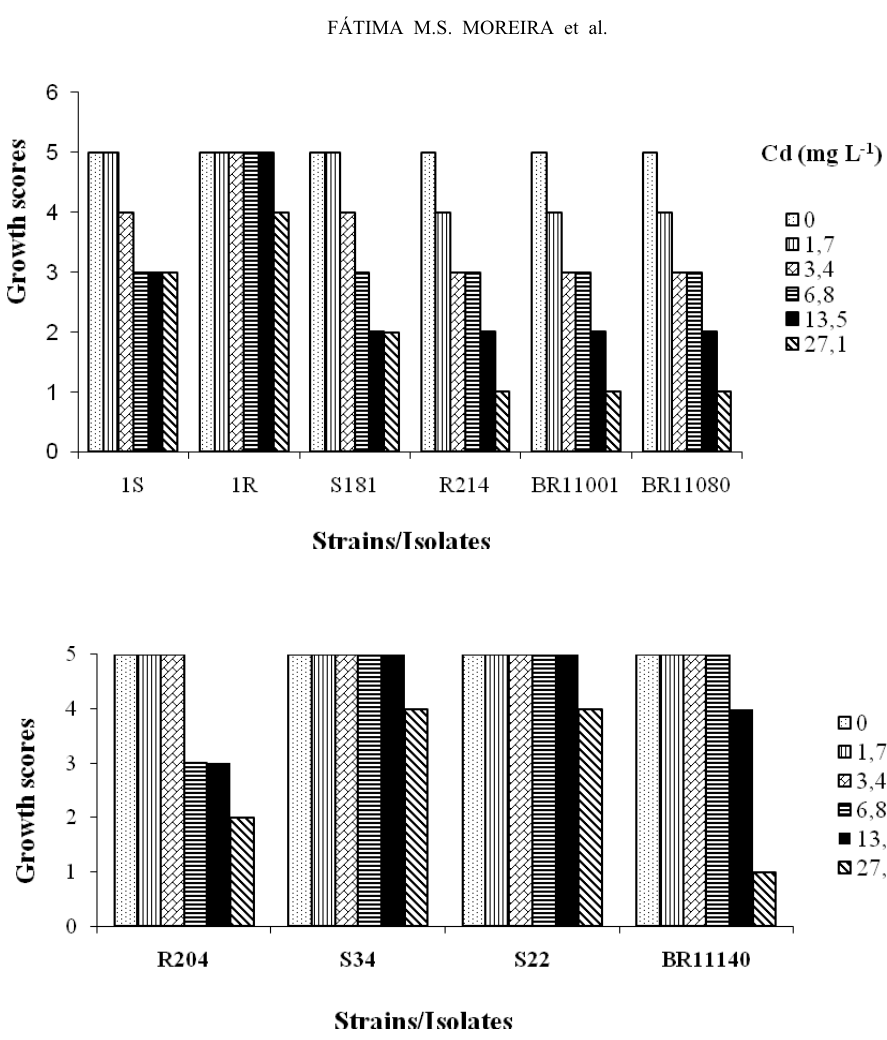
Fig. 2 – Growth scores of associative diazotrophic bacteria isolated from heavy metal contaminated area and type strains in potato dextrose agar medium supplemented with different concentrations of Cd 2+ (mg L -1 ) ten days after inoculation. a) Azospirillum lipoferum (1S and BR 11080 T ) and A. brasilense (1R, S181, R214, BR 11001 T ); b) A. amazonense (R204, S34, S22, BR11140 T ). 0 = no visual growth, 1 = very reduced growth, 2 = low growth, 3 = intermediate growth, 4 = abundant growth, 5 = very abundant growth as compared to the growth of the strain/isolate in the same medium without heavy metal